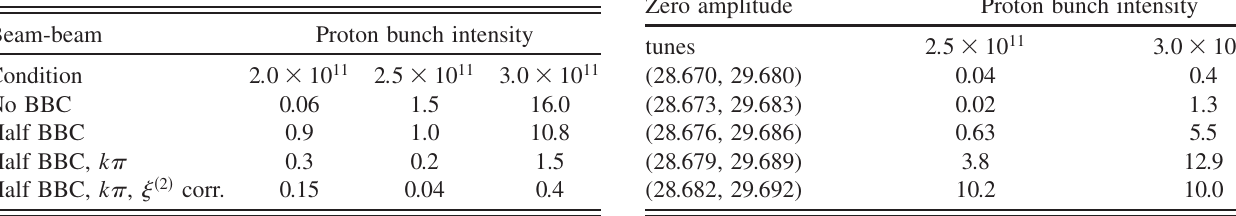
TABLE II. Proton beam loss rates (in units of %/hour) under different beam-beam compensation condition.